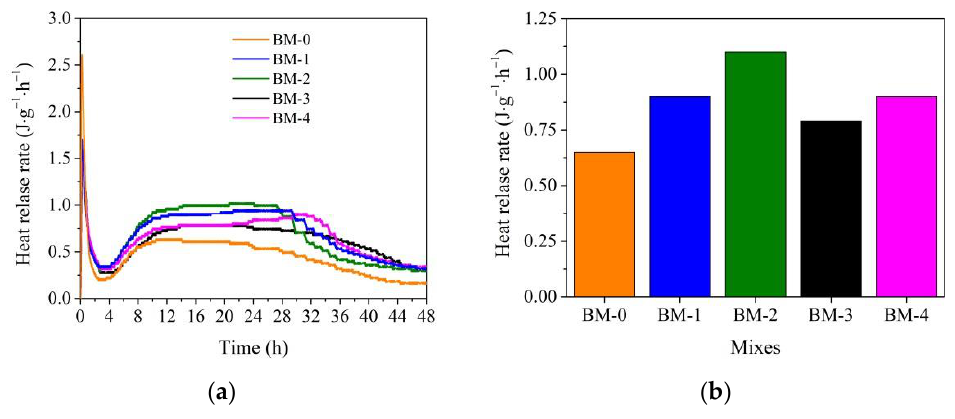
Figure 5. The heat release rate for BM-0 – BM-4 mixes: ( a ) curves; ( b ) maximum values.